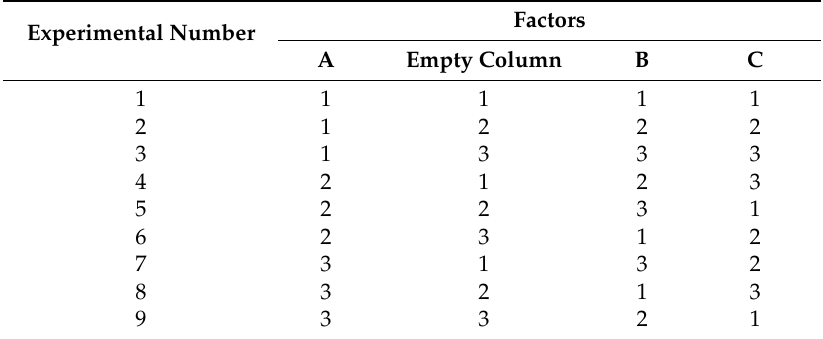
Table 3. The final orthogonal experimental design scheme of the straight cone nozzle structure parameters.